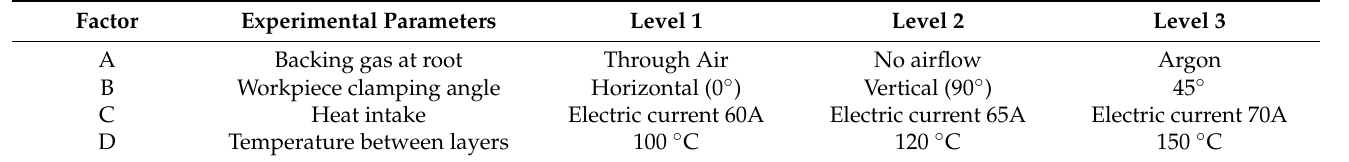
Table 3. Taguchi direct cross-tabulation table control factor and three levels comparison table.